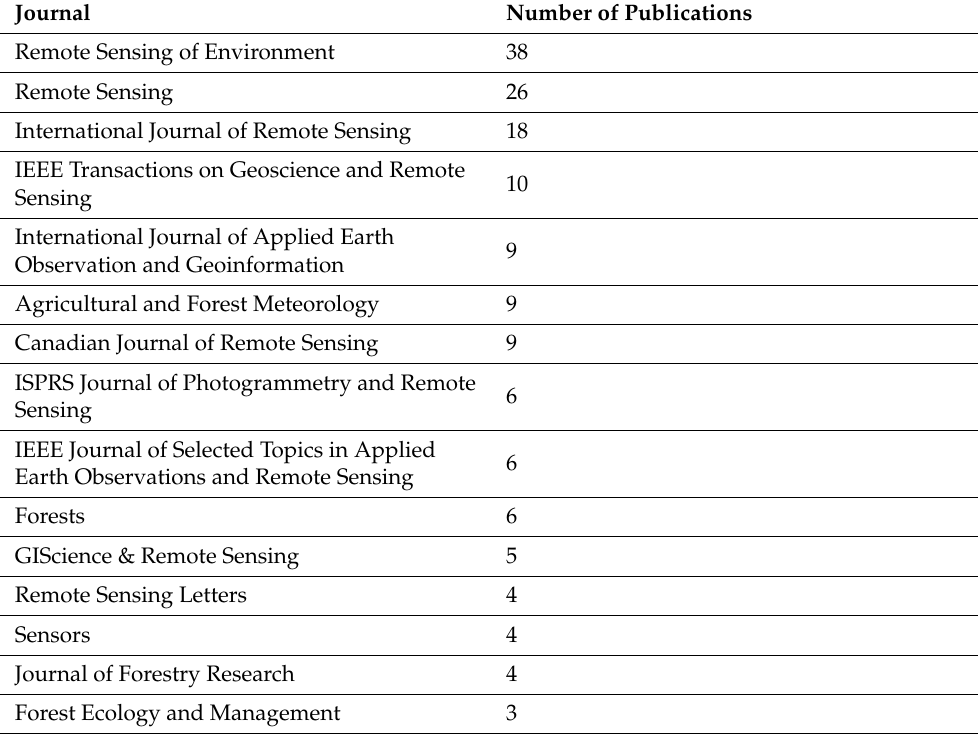
Table 1. Journal list and the number of articles for forest, crop and